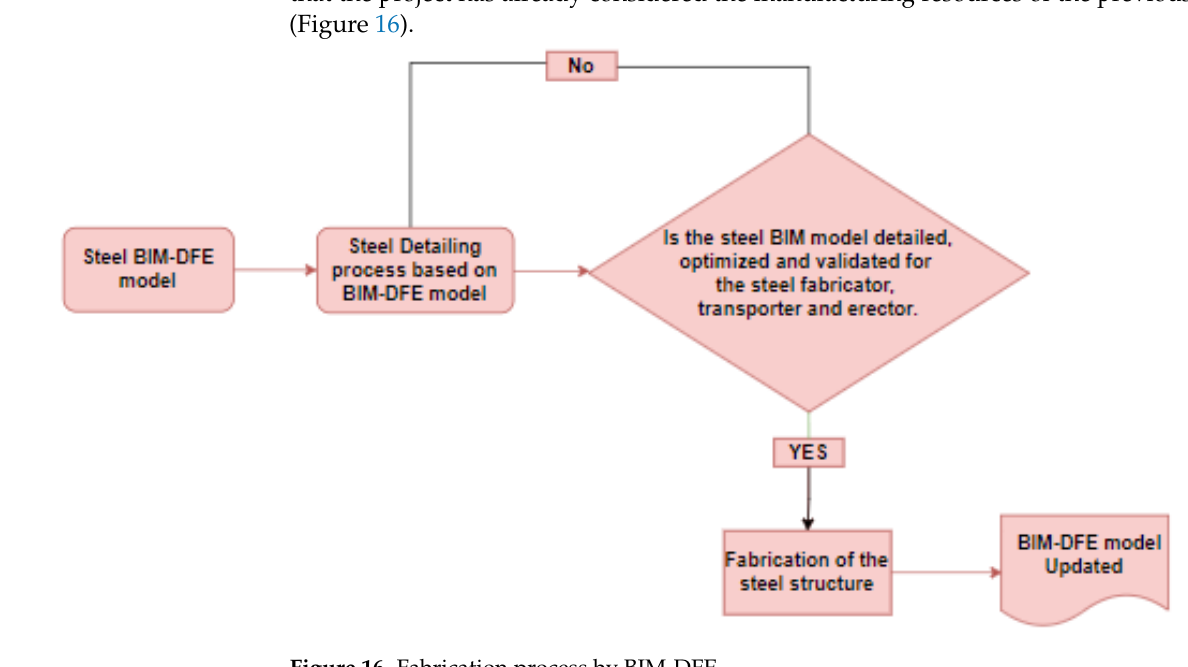
Figure 16. Fabrication process by BIM-DFE.